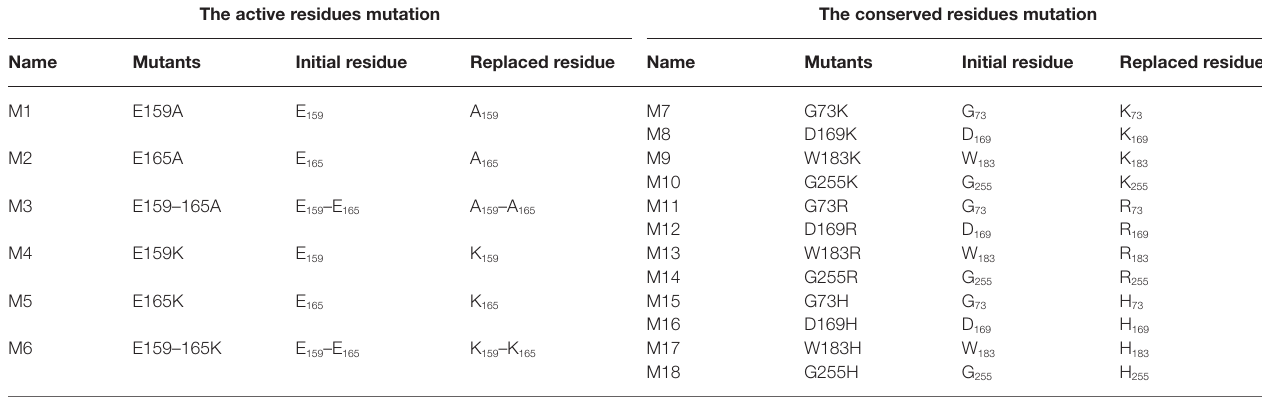
TABLE 1 | Mutational information of Car1383.